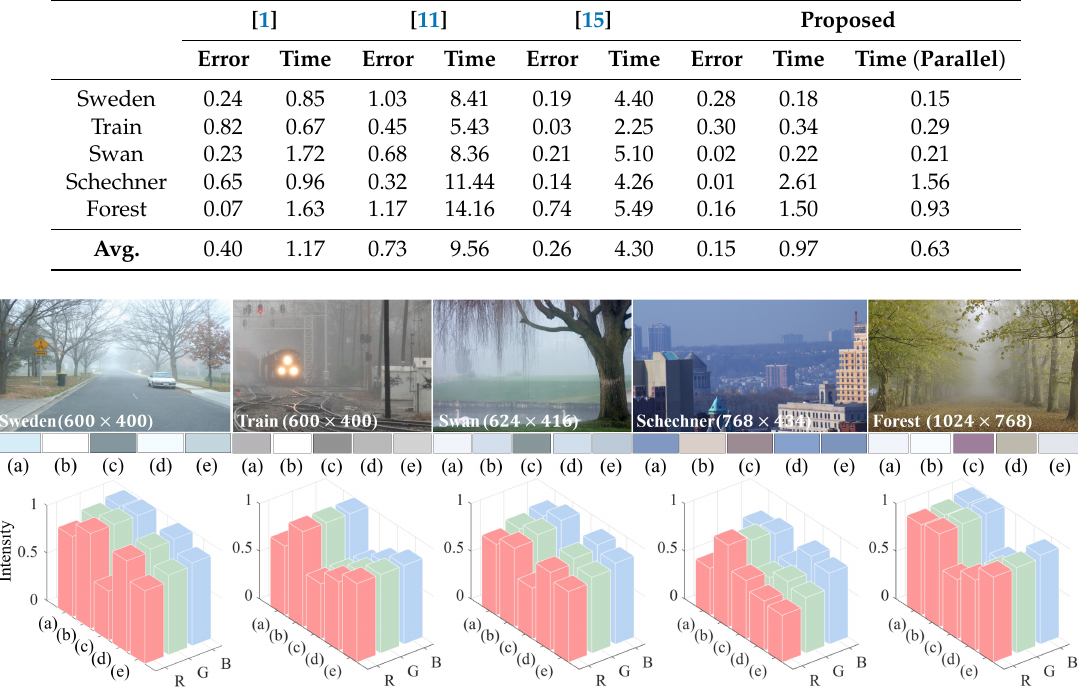
Table 1. Objective assessments of atmospheric light estimation using the l 2 -error and processing time (seconds) [20].